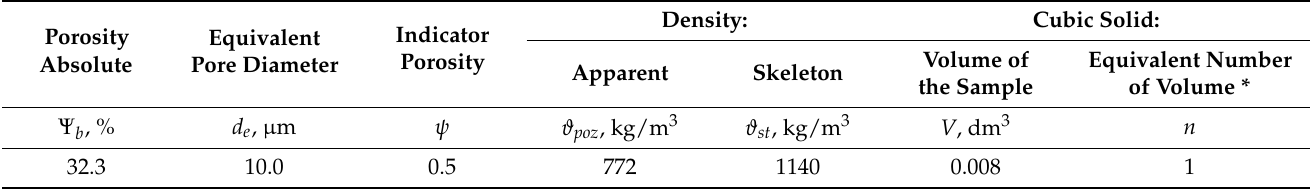
Volume of Equivalent Number the Sample of Volume